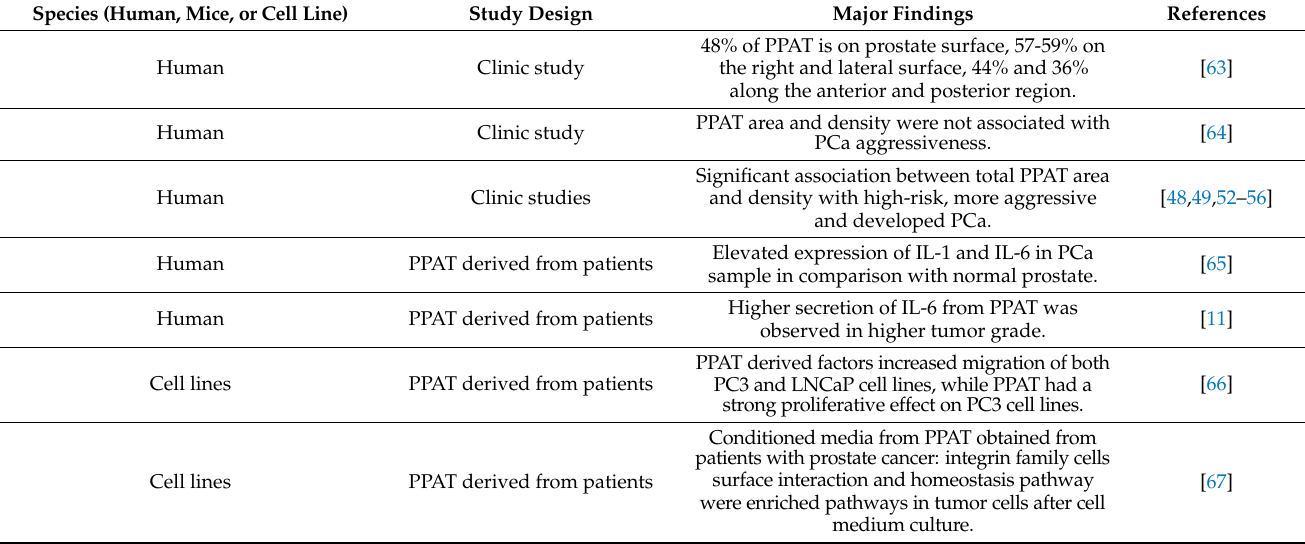
Table 2. Periprostatic adipose tissue (PPAT) and prostate cancer